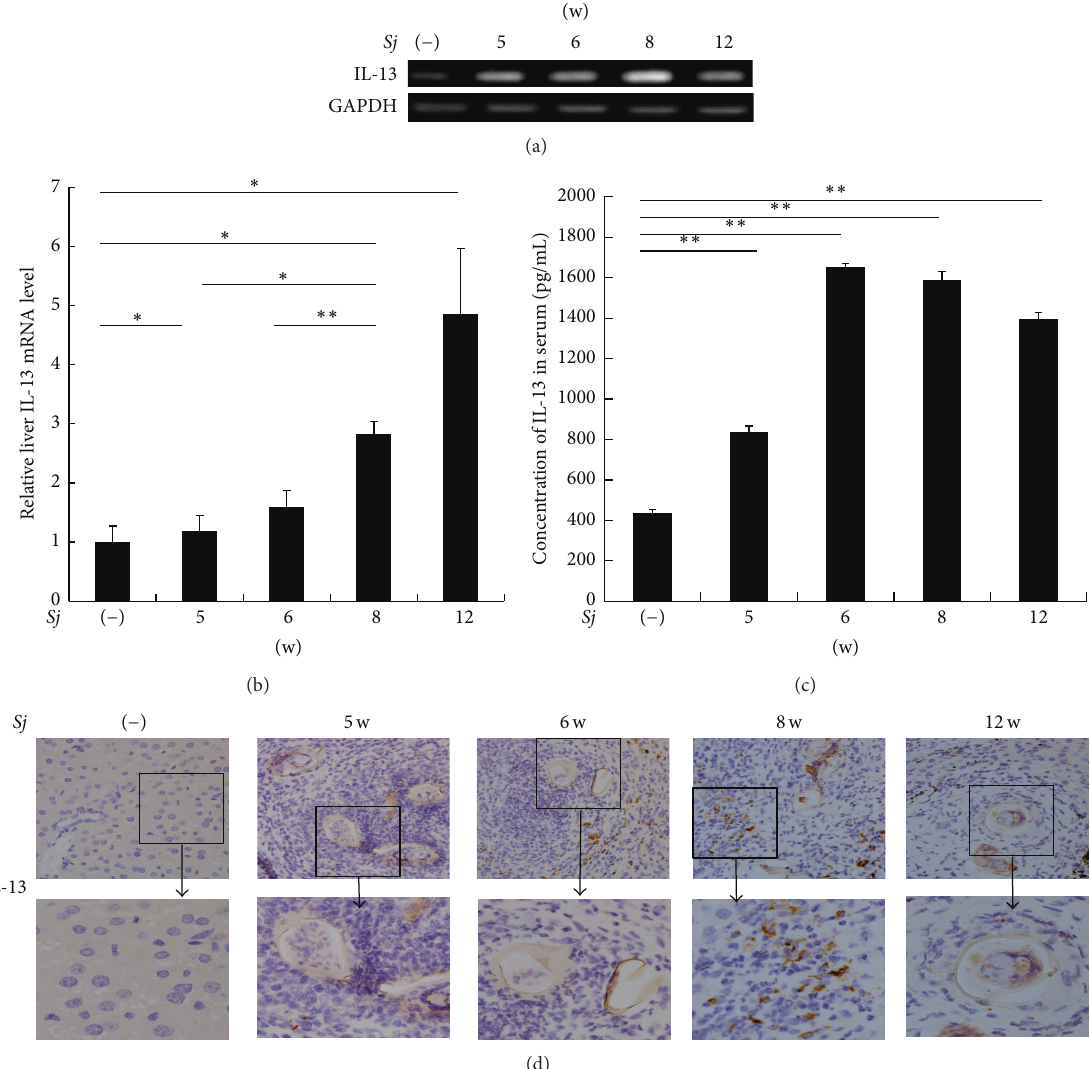
Figure 2: IL-13 level was associated with hepatic fibrosis after Sj infection. (a, b) IL-13 mRNA level in BALB/c mice liver is upregulated at weeks 5, 6, 8, and 12 after Sj infection, as determined through RT-PCR and SYBR Green based Q-PCR. GAPDH is detected as an internal control. Data are presented as mean ± SD from eight mice per group. ∗ 𝑃 < 0.05 and ∗∗ 𝑃 < 0.01 . (c) Concentration of IL-13 in mice sera is tested by ELISA. Data are presented as mean ± SD from eight mice per group. ∗ 𝑃 < 0.05 and ∗∗ 𝑃 < 0.01 . (d) Localization and expression level of IL-13 protein in BALB/c mice liver is shown through IHC assay at weeks 5, 6, 8, and 12 after Sj infection. Representative IL-13 staining sections are shown at primary 40x